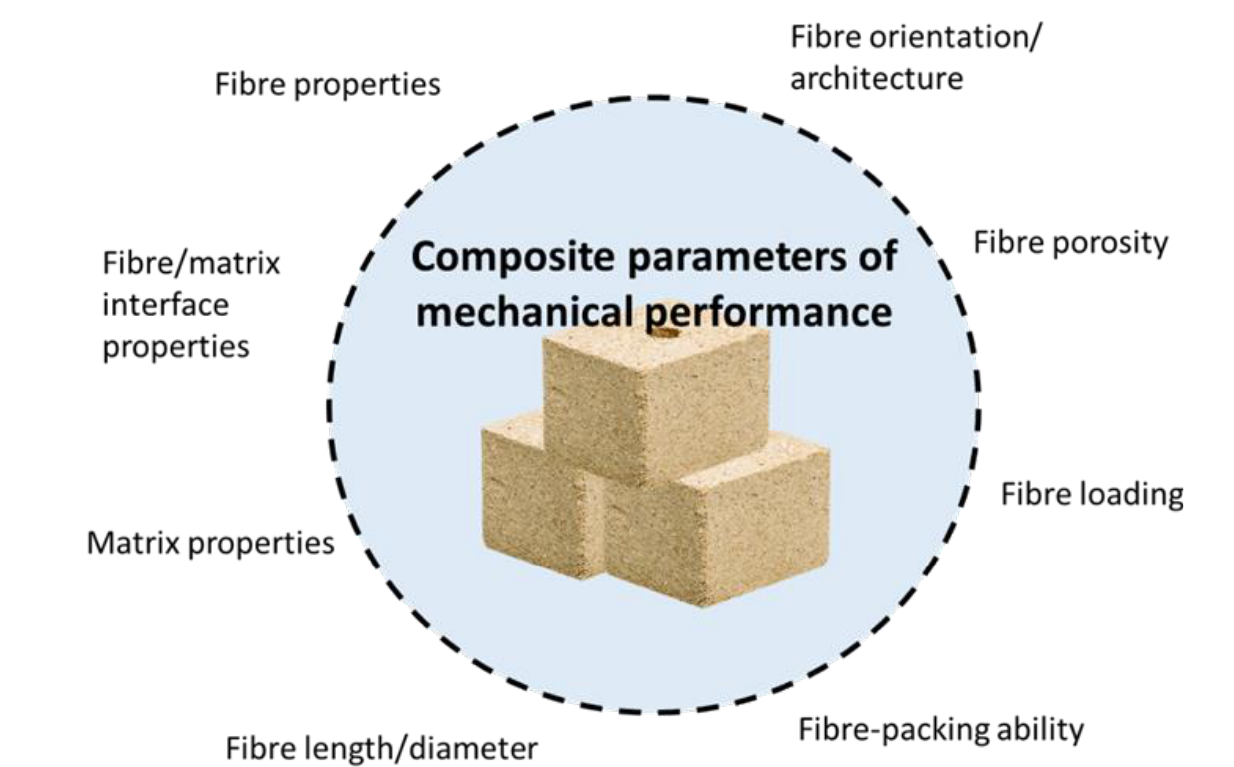
Figure 4. Mechanical properties of the composite.